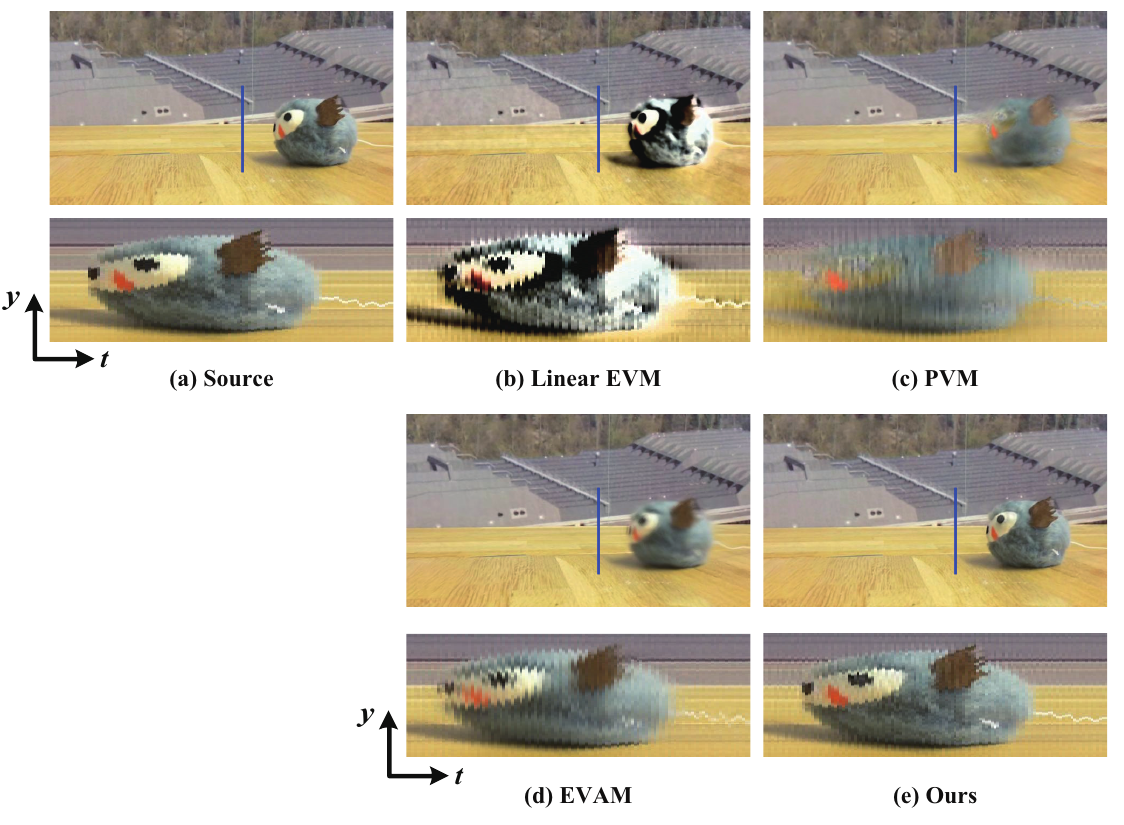
Figure 4. ( a ) Original video from [17]; and ( b – e ) magnification results using: Linear EVM [6], PVM [12], EVAM [17] and our algorithm, respectively. For each method, we show the spatio-temporal Y − T slice of the blue line marked in a frame from corresponding video. The goal of magnification is to reveal the vibration of cat toy while not induces artifacts and blurring. As can be seen from the magnification results, EVAM [17] and our algorithm can realize this goal while the linear EVM [6] and PVM [12] fail. A gun shooting sequence from [15] is used for verifying the proposed method on the video in presence of large and nonlinear motion. Figure 5 shows the magnification results of a gun shooting sequence containing various motions. The different magnification techniques are applied for magnifying the small moves in the arm muscles due to the strong recoil of the shot. For each approach we show the spatio-temporal Y − T slice at the upper arm, forearm and the hand indicated with the solid red, green and blue line over the video. The linear EVM [6] generates large haloes and artifacts because of the movement of the arm. The PVM [12] induces ripples and motion blurring which overshadow the subtle motion in the arm. The EVAM [17] can amplify the small muscle movement in the upper arm and forearm, but is difficult to deal with the motion at the hand. Our algorithm can handle the large and nonlinear motion while magnifying the subtle muscle